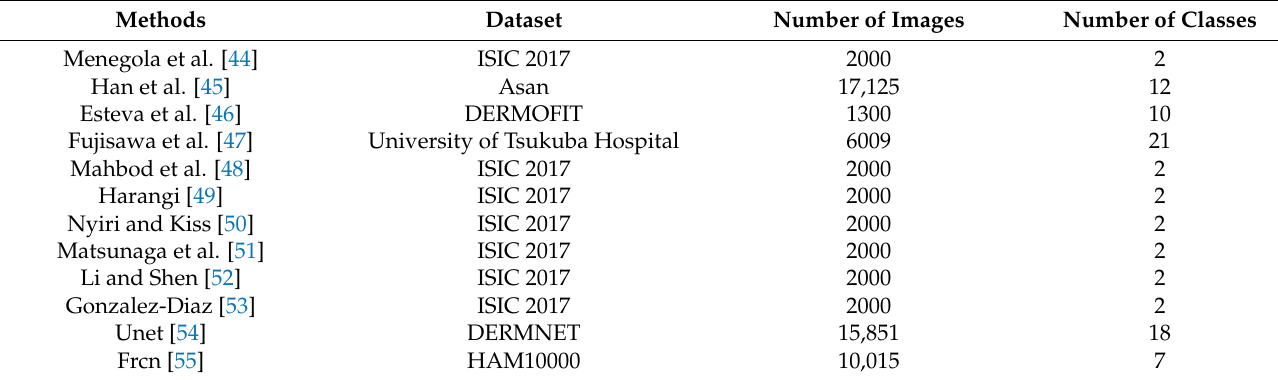
Table 1. Datasets of all DL methods.